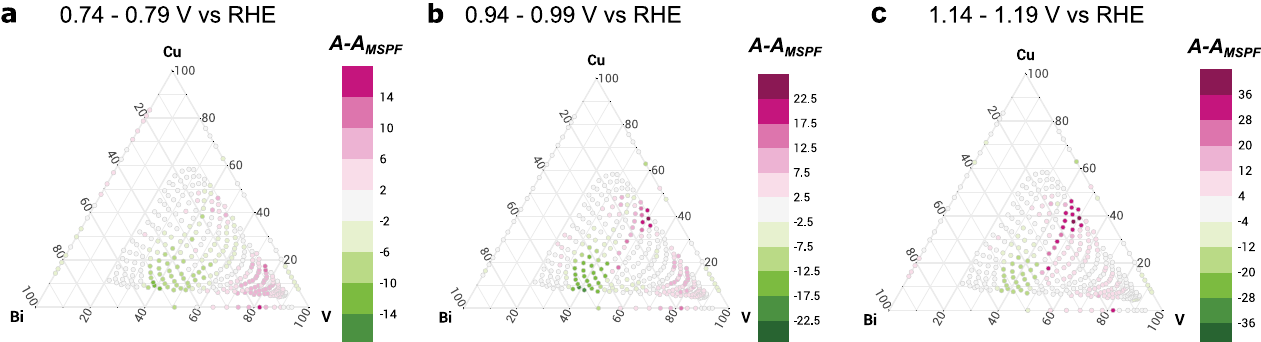
Fig. 3 Phase interaction detection. The residual from the factorization model of Fig. 2 is averaged over three different ranges of photoelectrochemical potential to ascertain whether a given composition outperforms (positive residual) or underperforms (negative residual) the expectation from materials structure – property factorization model at ( a ) 0.74 – 0.79 V vs RHE; ( b ) 0.94 – 0.99 V vs RHE; and ( c ) 1.14 – 1.19 V vs RHE.